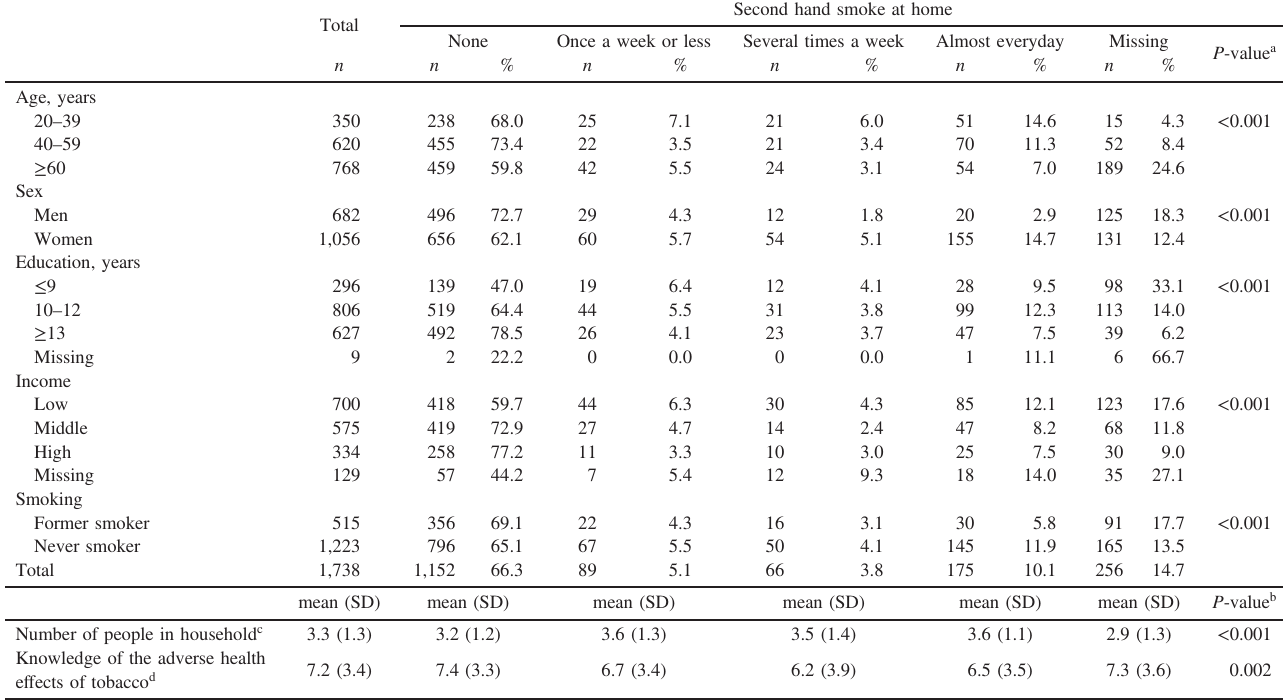
Table 1. Characteristics of the analytical participants for secondhand smoke at home ( n =